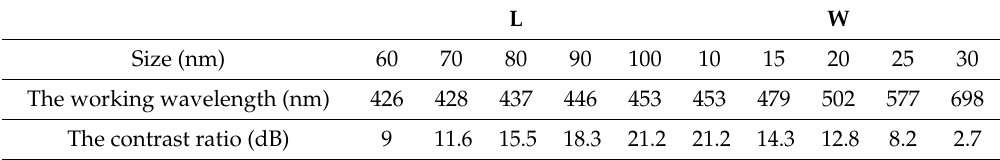
Table 2. The contrast ratio and the working wavelength of di ff erent geometric parameter when the metal strip number is